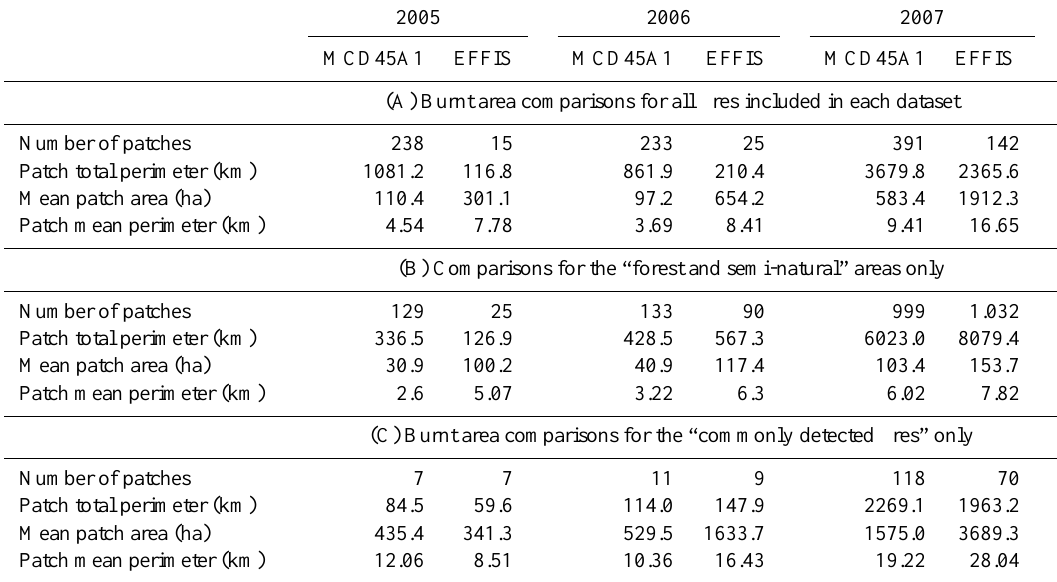
Table 4. Patch metrics analysis conducted for different dataset subset scenarios comparing the burnt area estimates from the MCD45A1 & EFFIS operational products for the years 2005–2007.